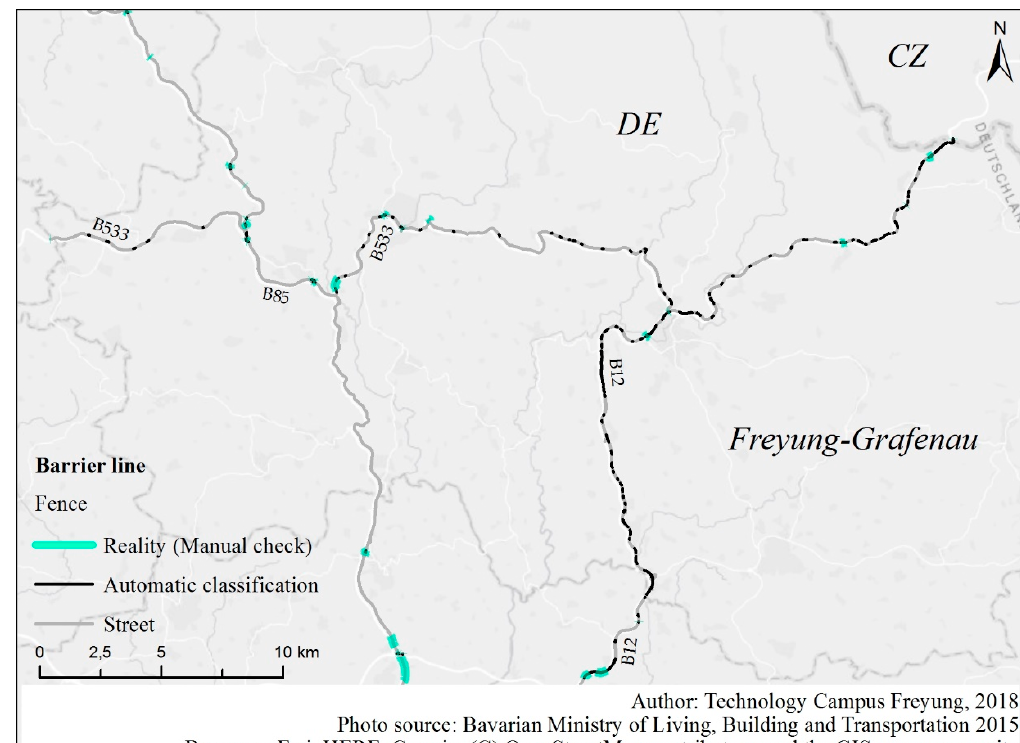
Figure 7. Map of classified fences (black line) in comparison to reality (manual check, turquoise line).